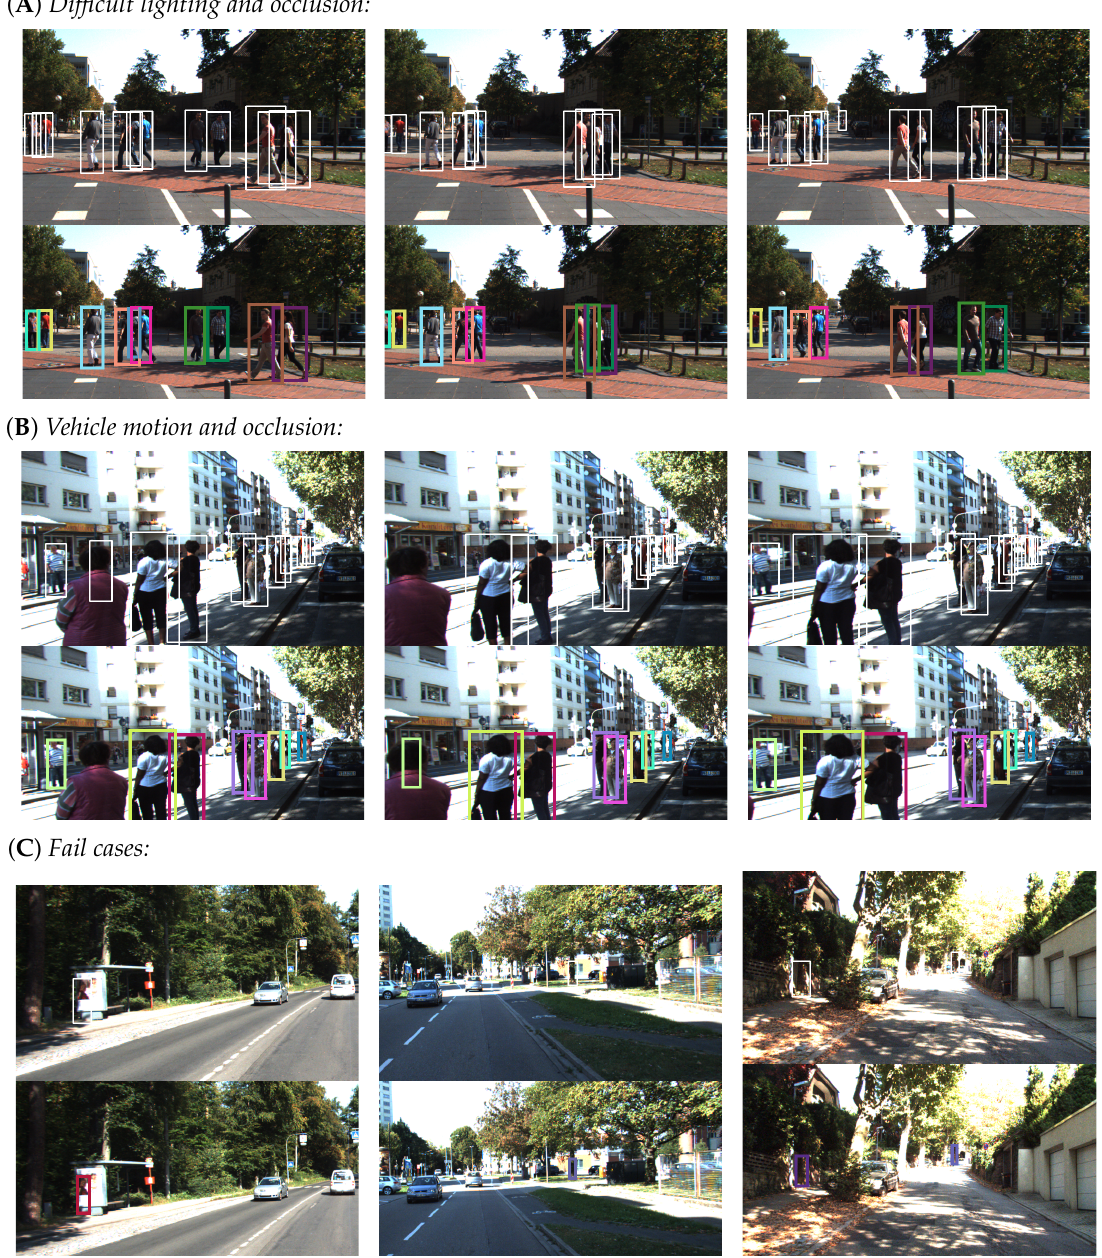
Figure 9. Examples of our tracking output in typical situations that are considered difficult in a classical tracking setup. Frames with raw pedestrian detections are shown on top of tracked pedestrians for the respective sequence. In ( A ), the focus is on the pair of people (green tracklets) passing with the other pair of people and coming out from a tree shadow. While their appearance changes and there is a complete occlusion, they are effectively tracked. In ( B ), the focus is on the person across the street who gets occluded due to the motion. Our method is able to compensate for this motion and continue tracking when he becomes visible again. In ( C ), we show three situations of persistent clutter where our method is tracking random objects that resemble